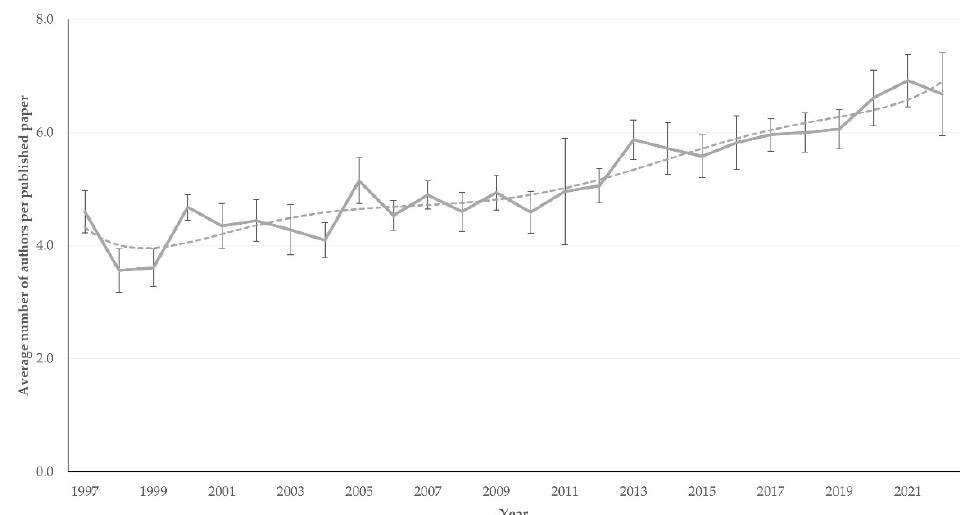
Figure 6. Average number of co-authors in papers on sheep and goats published annually during 1997–2022 from Greece (dashed line indicates trendline).